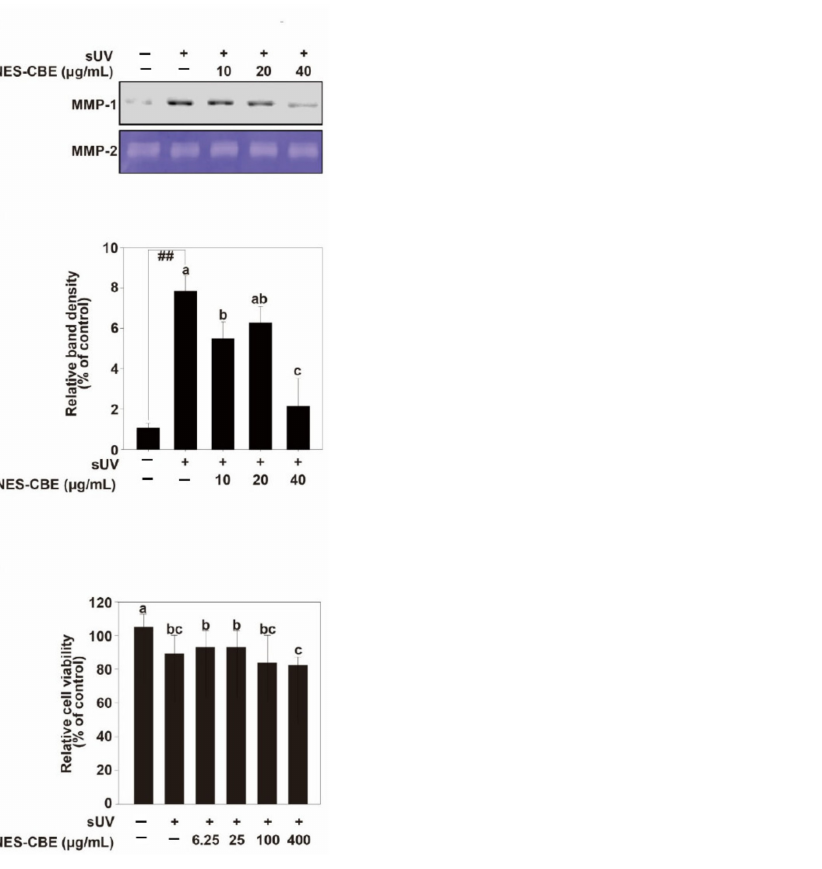
Figure 2. Effect of NES-CBE on solar ultraviolet (sUV)-induced matrix metalloproteinase (MMP)-1 protein expression. ( A , B ) HaCaT cells were seeded and incubated at 80% confluent. The cells